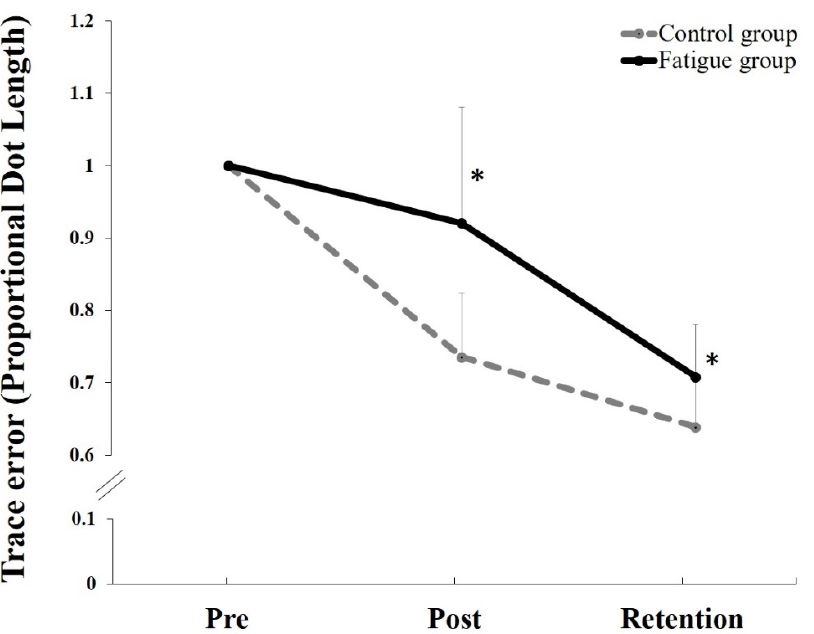
Figure 5. Normalized mean proportional trace error changes by groups (Control vs. Fatigue). Both groups improved in accuracy after motor skill acquisition tracing tasks and during the retention ( p < 0.001). The control group outperformed the fatigue group in both post-motor skill acquisition and during retention (* p < 0.05). Error bars represent SD.